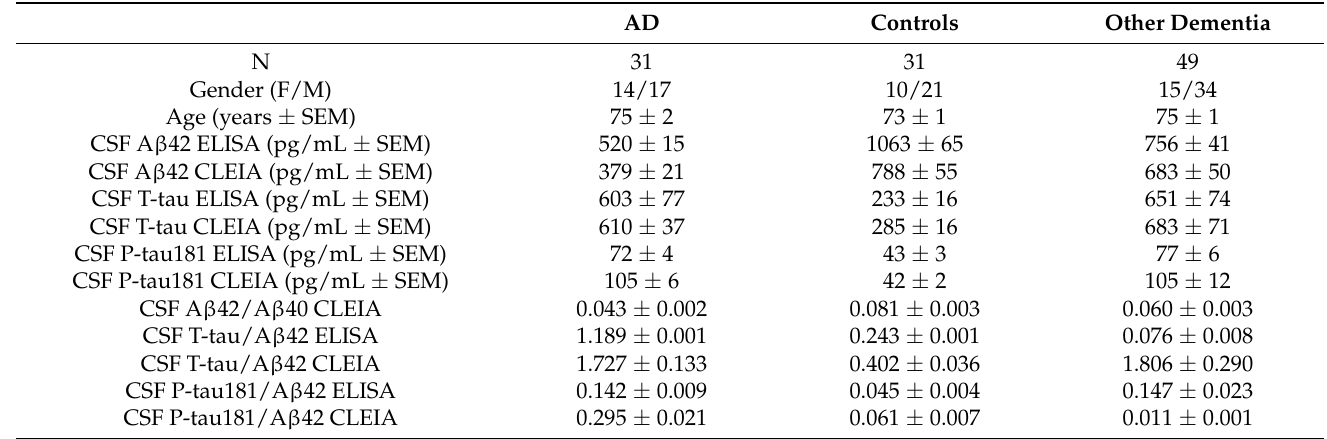
Table 1. Characteristics of the population.